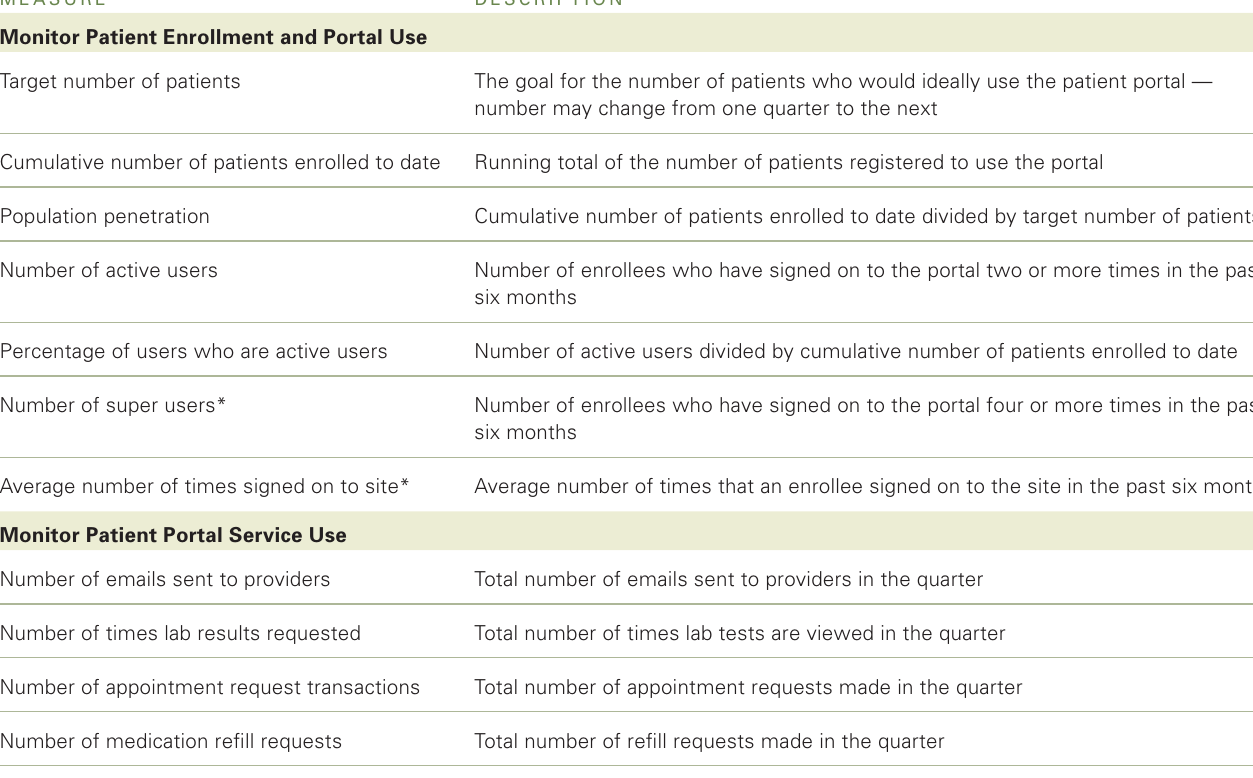
table 2. Evaluation Measures to Monitor Patient Enrollment, Portal and Service